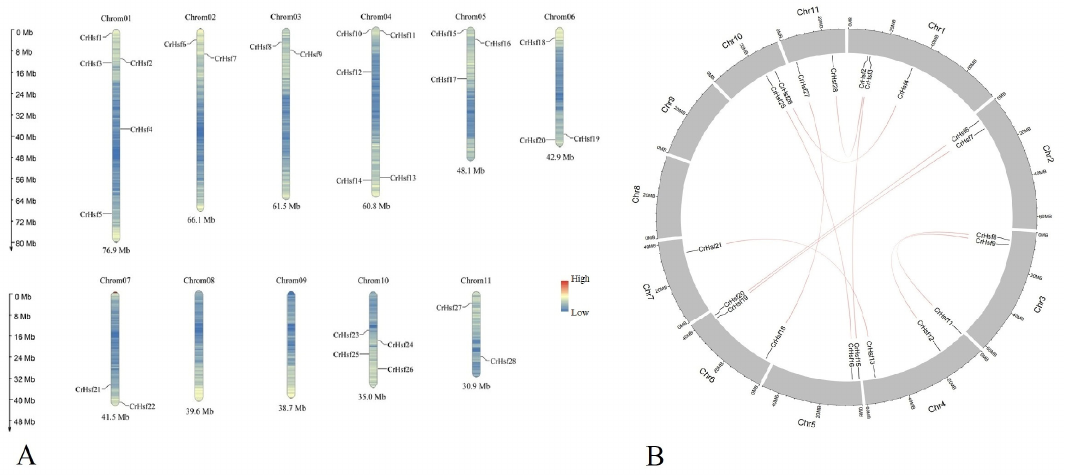
Figure 3. ( A ) Chromosomal distribution of 28 CrHsf genes in the C. rosea genome. The scale of the chromosome is showed in millions of bases (Mb); ( B ) the distribution of segmental duplication of Cr Hsf s in C. rosea chromosomes.